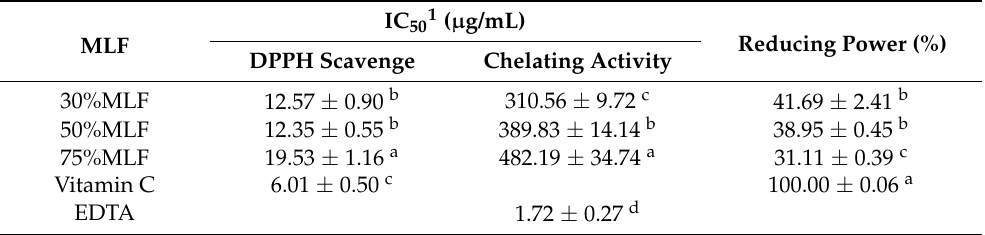
Table 1. Antioxidative activities of the MLFs.